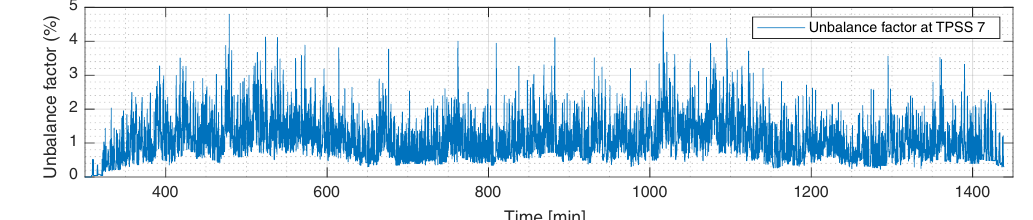
a three-phase 63 kV voltage level the short circuit power at substation #7 is S SC3 φ = 800 MVA. Accordingly, the corresponding V UF is given (in percentage) in Figure 7.